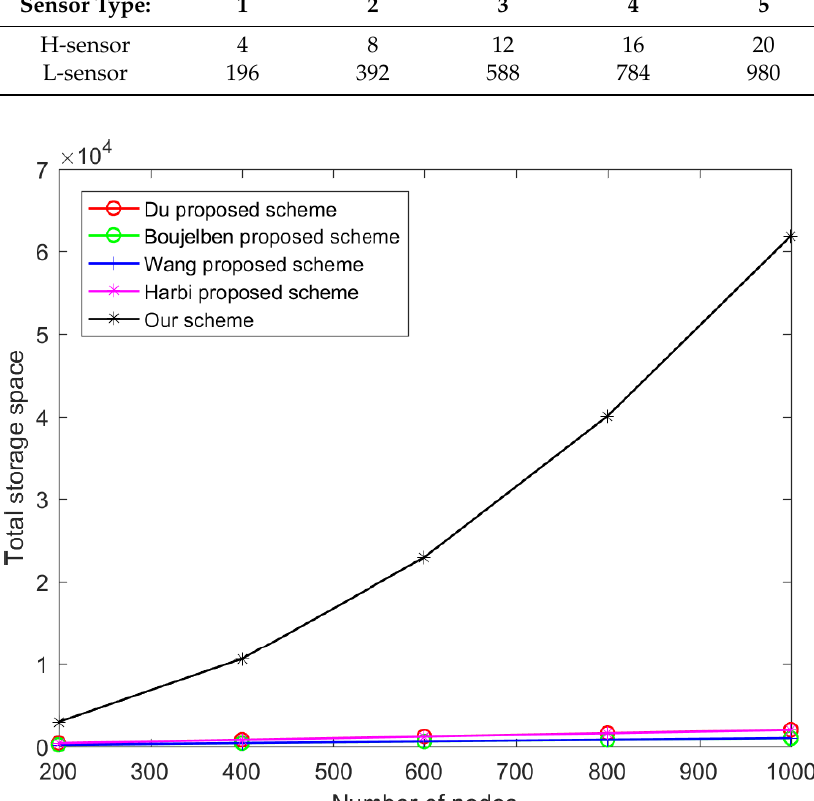
Figure 3. The comparison of key storage cost.